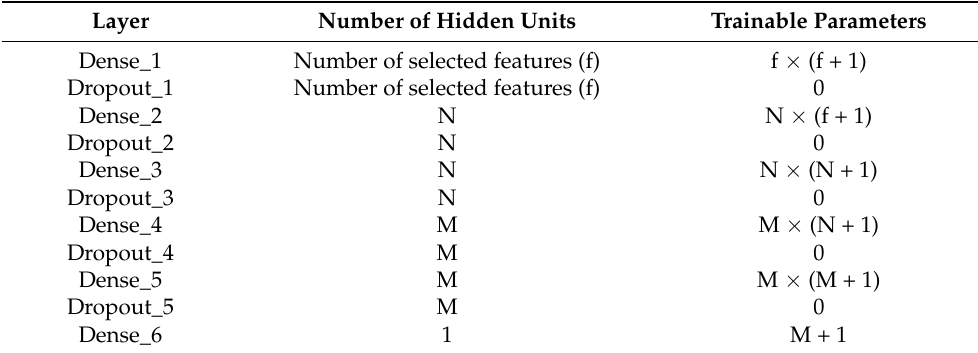
Table 2. Multilayer perceptron summary